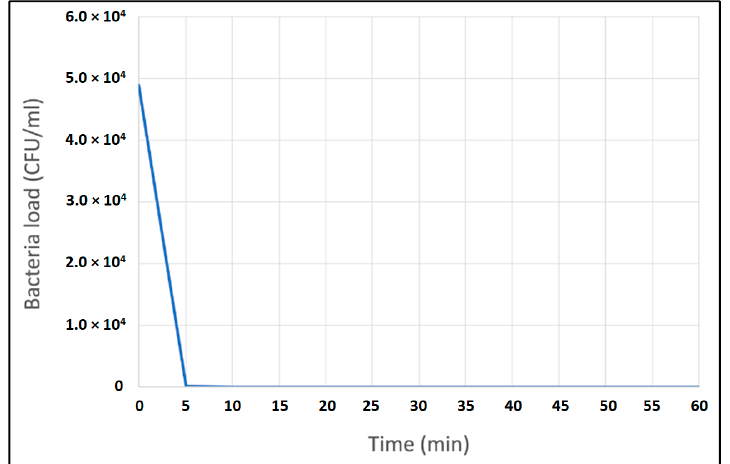
Figure 9. Results of the antibacterial test in the on-demand water disinfection experiment.